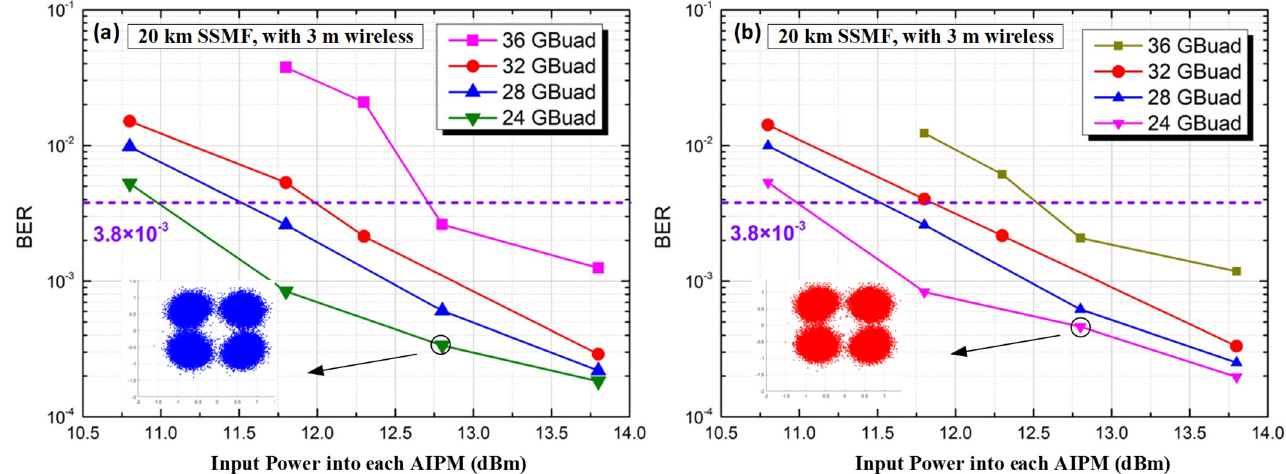
Figure 5. BER versus input power into each AIPM over one span of 20-km SSMF and 3-m wireless transmission. ( a ) X-polarization; ( b ) Y-polarization.